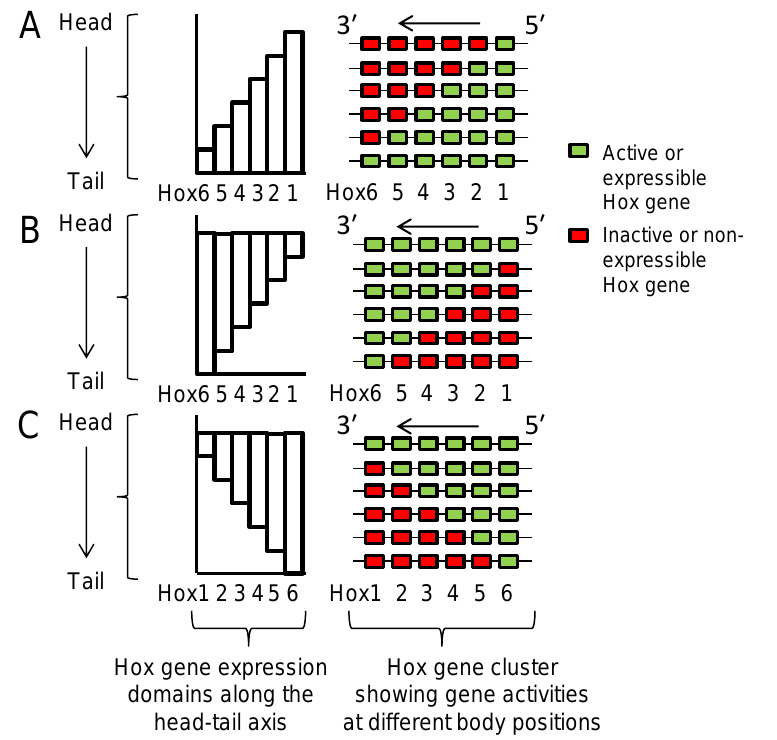
Figure 8. Potential head-to-tail Hox gene expression polarities as alternatives to that found in nature (Figure 2A). Each alternative ( A – C ) displays its own form of spatial collinearity. Arrows show directions of transcription